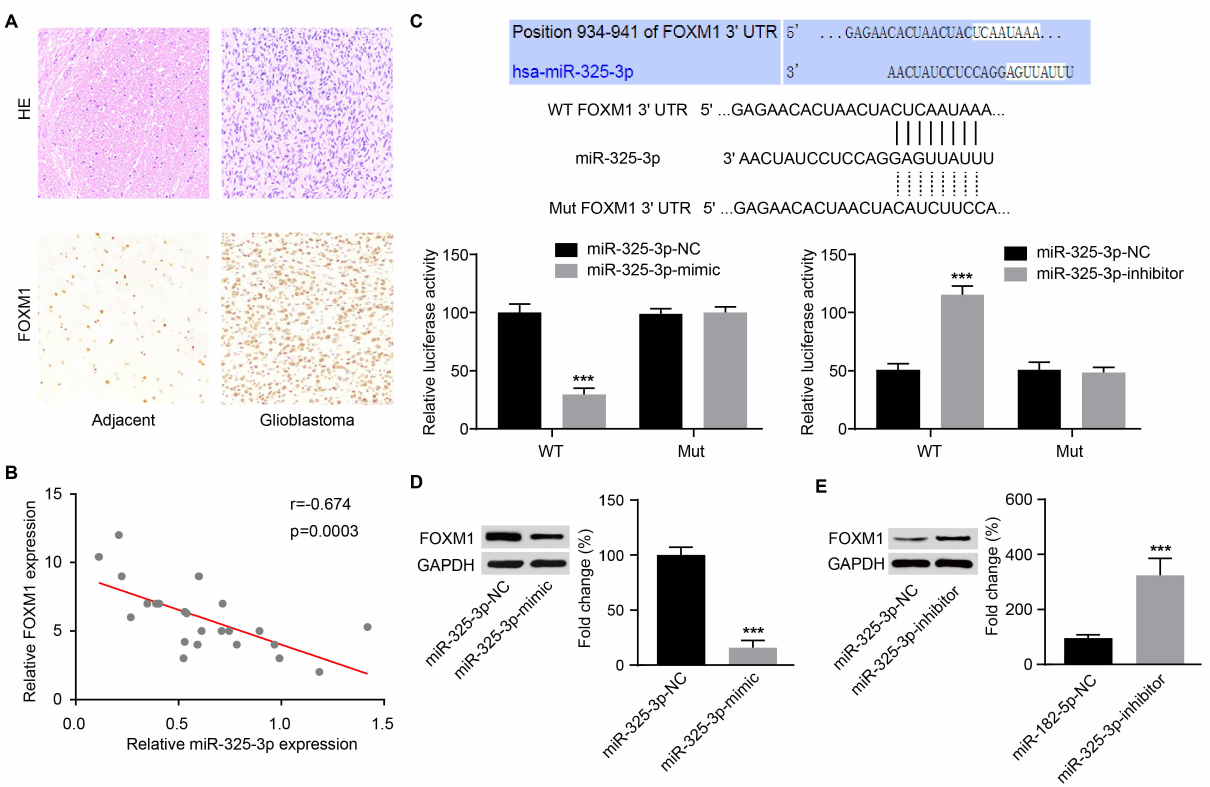
Fig. 5. FOXM1 is a direct target for miR-325-3p in glioma. (A) Tissue comparison using H&E staining and IHC, showing higher levels of FOXM1 in glioma tissues. (B) An inverse relationship between FOXM1 and miR-325-3p in glioma tissues. (C) FOXM1 was predicted to be a target for miR-325-3p, based on the Targets can database, and the WT and Mut luciferase reporter plasmids were generated to perform dual-luciferase reporter assays. (D,E) The expression of FOXM protein after transfection with NC, mimic, or inhibitor in U87 cells. Data are presented as the mean ± SEM, *** p < 0.001, compared to the miR-325-3p-NC